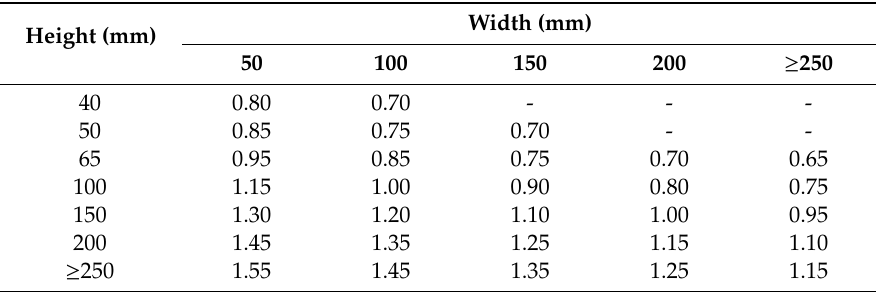
Table 3. The values of the shape factor d,